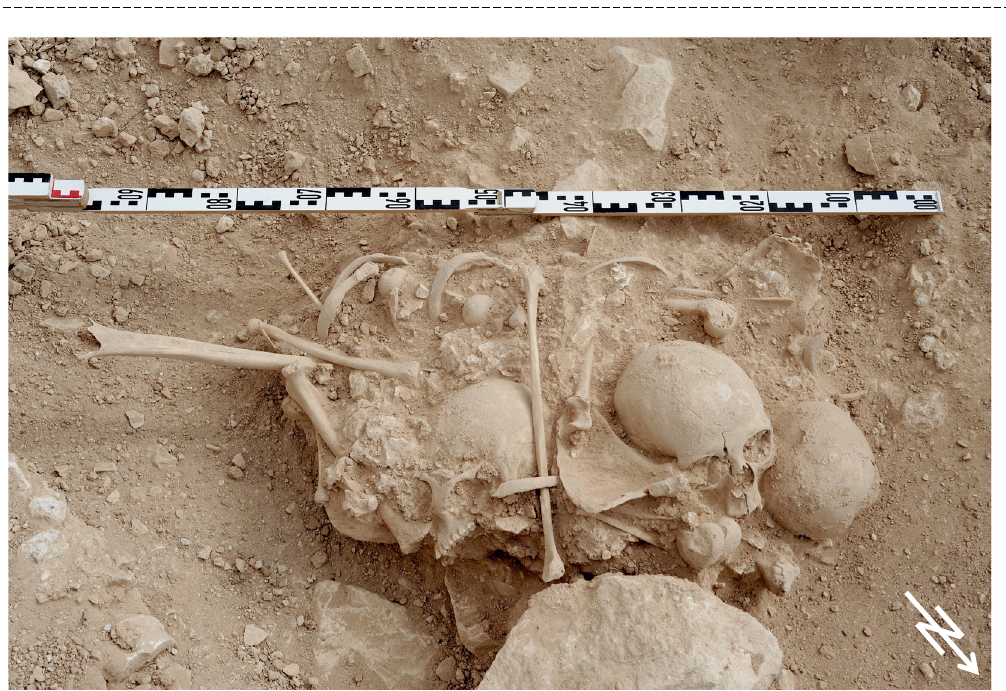
Figure 5: Field photographic documentation of Structure no 1 ( Pièce 5 ) before excavation ( top ) and after excavation ( bottom ) . Photographs by Vigouroux ( 2015 )